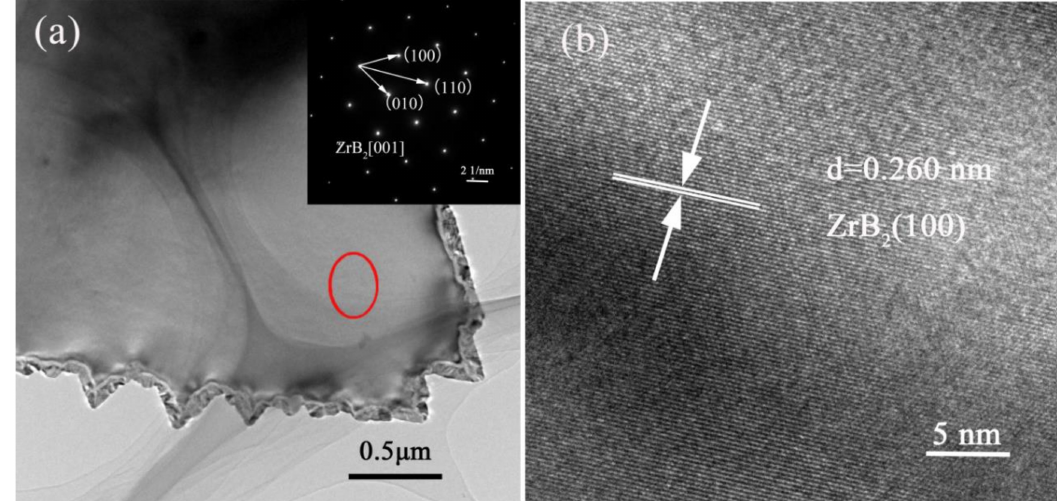
Figure 6. ( a ) Low-resolution TEM image and SAED (inserted in Figure 4 a ), and ( b ) high-resolution TEM image of the as-prepared ZrB 2 -SiC powders fired at 1250 ◦ C for 20 min.